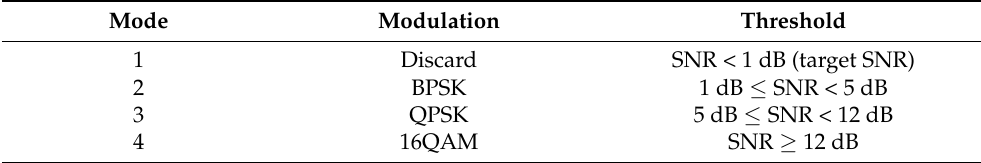
Table 5. Switching threshold for the cluster-based adaptive modulation in the river experiment.